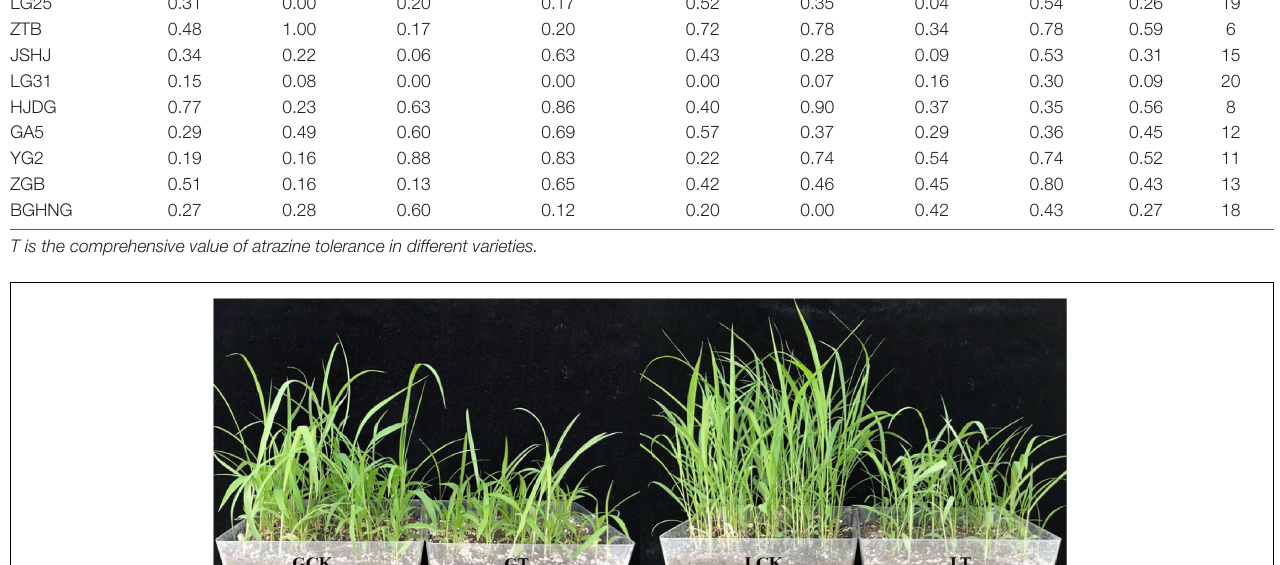
were significantly upregulated. In the “LCK vs. LT” comparison, were obtained from all samples ( Figure 3A and Supplementary Table 5 ) and divided into four groups according to PCA ( Figure 3B ). On the basis of FC of ≥ 1.5, the numbers of upregulated and downregulated metabolites in GCK and GT and LCK and LT were 82 and 95 and 110 and 120, respectively ( Supplementary Table 5 ). Moreover, these DEMs were identified